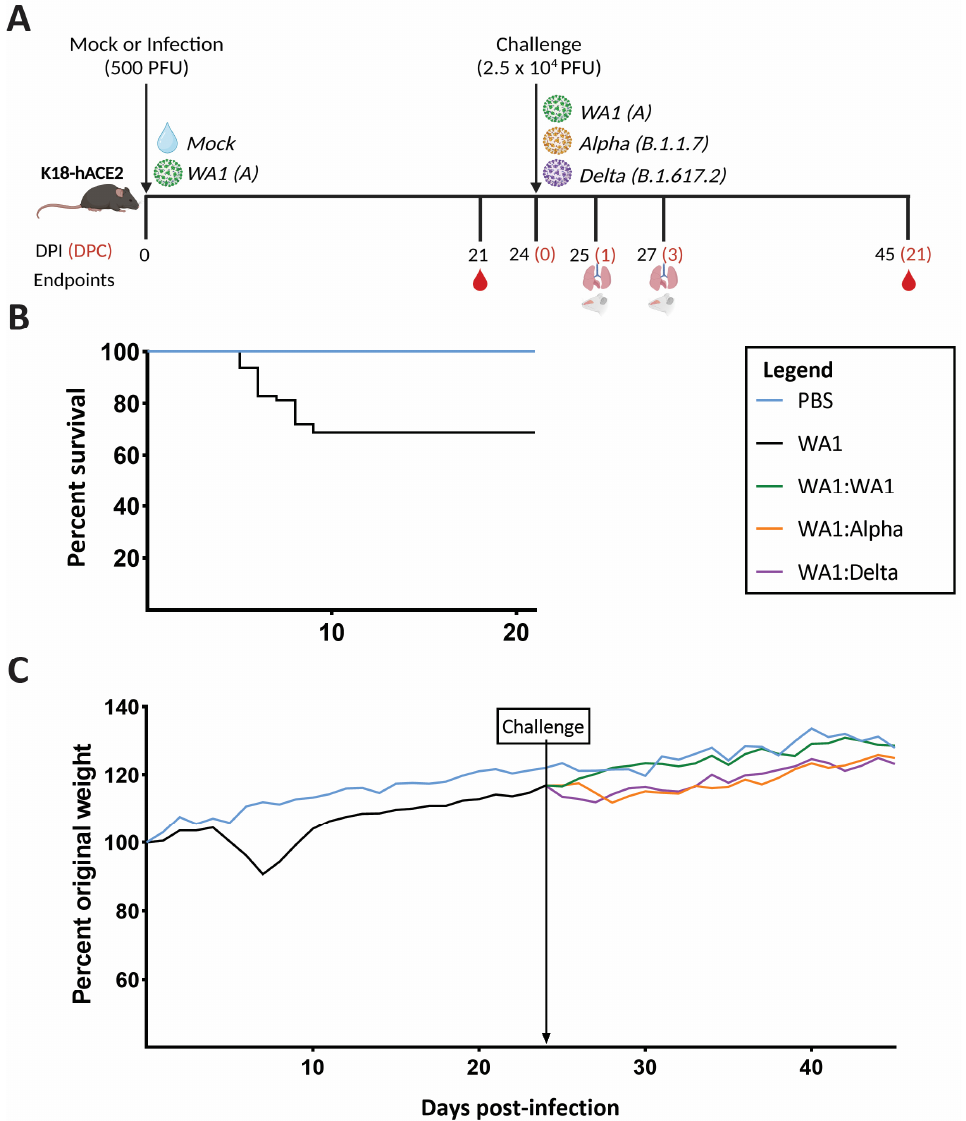
Figure 1. Study timeline and clinical outcomes. ( A ) Mice (n = 104) were inoculated intranasally with either PBS (sham) (n = 40) or 500 PFU of WA1 (n = 64). At 24 days postinfection (dpi) or 0 days postchallenge (dpc), WA1-challenged mice were inoculated with 2.5 × 10 4 PFU of WA1 (n = 12), Alpha (n = 12), or Delta (n = 12) (noted by “Challenge” and arrow). In addition, 24 mice were infected for the first time from the PBS control group with WA1 (n = 8), Alpha (n = 8), or Delta (n = 8) or PBS (n = 8). At 25 (1 dpc) and 27 (3 dpc) dpi, lungs and/or nasal turbinates were collected for RNA-Seq. At 21 and 45 dpi, blood was collected to test neutralizing titers. The figure was created with Biorender.com. ( B ) The survival graph of mice infected with WA1 (n = 64) shows a 31.3% mortality. ( C ) For clarity, the average of the percent of original weight at 0 dpi for the 5 groups of mice is shown. Prior to and through 24 dpi, PBS (blue line) and WA1 (black line) inoculated mice are shown. Beginning at 25 dpi, the average percent of weight change of the WA1 infection plus the challenge virus are shown as green (WA1), orange (Alpha), and purple (Delta) lines. The blue line shows the average weight change of PBS. Nonlinear regression modeling of each group’s average percent weight change graph between 24 and 28 dpi showed a slope of 1.08 for WA1-challenged mice and a slope of − 0.67 and − 1.44 for Alpha- and Delta-challenged mice, respectively. A one-way ANOVA showed p values of 0.0129 and 0.0199 for the groups WA1:Alpha and WA1:Delta, respectively, suggesting a significant difference between the homologous- and heterologous-challenged groups. Abbreviations: dpi—days postinfection; dpc—days postchallenge.